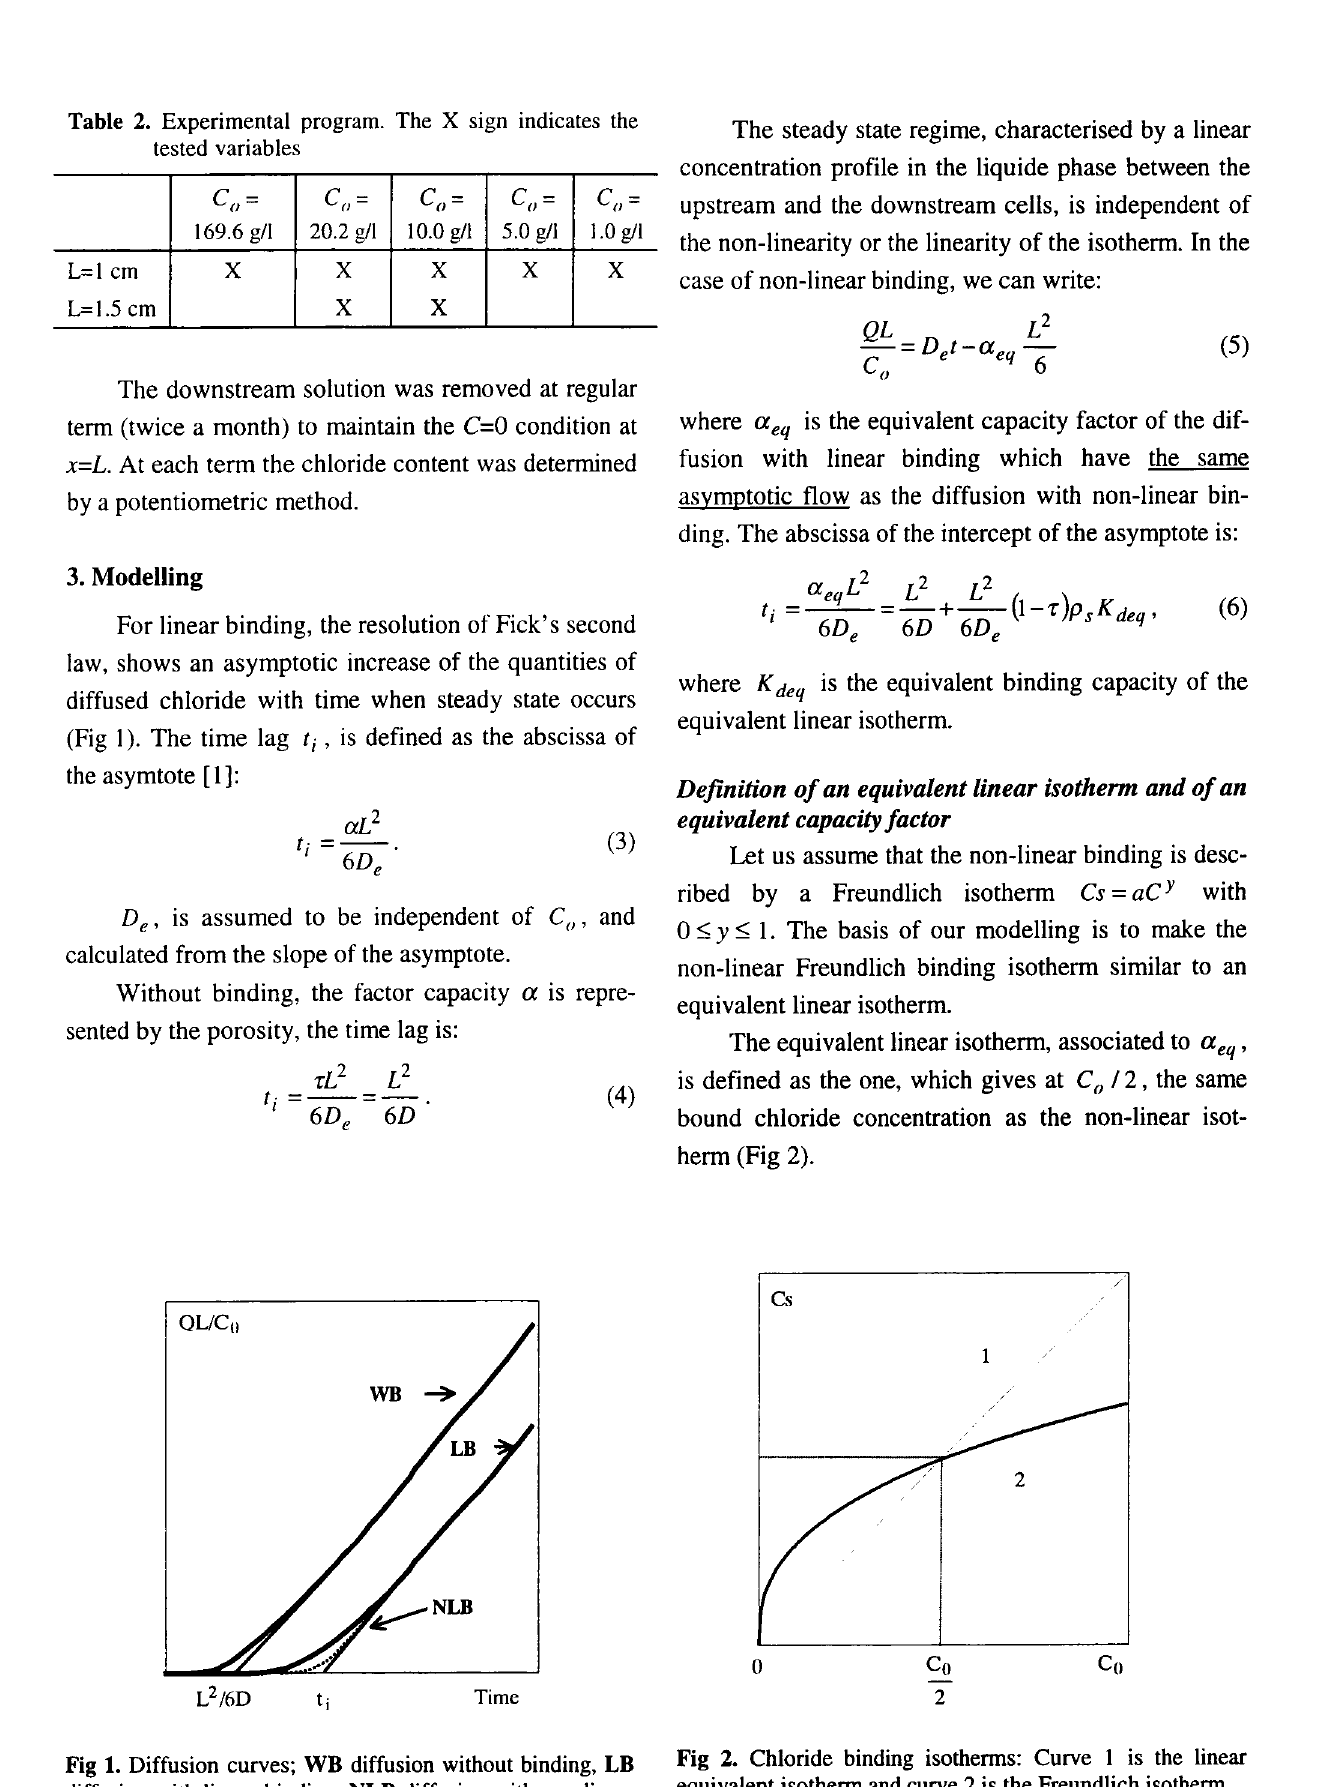
Fig 1. Diffusion curves; WB diffusion without binding, LB diffusion with linear binding, NLB diffusion with non-linear binding